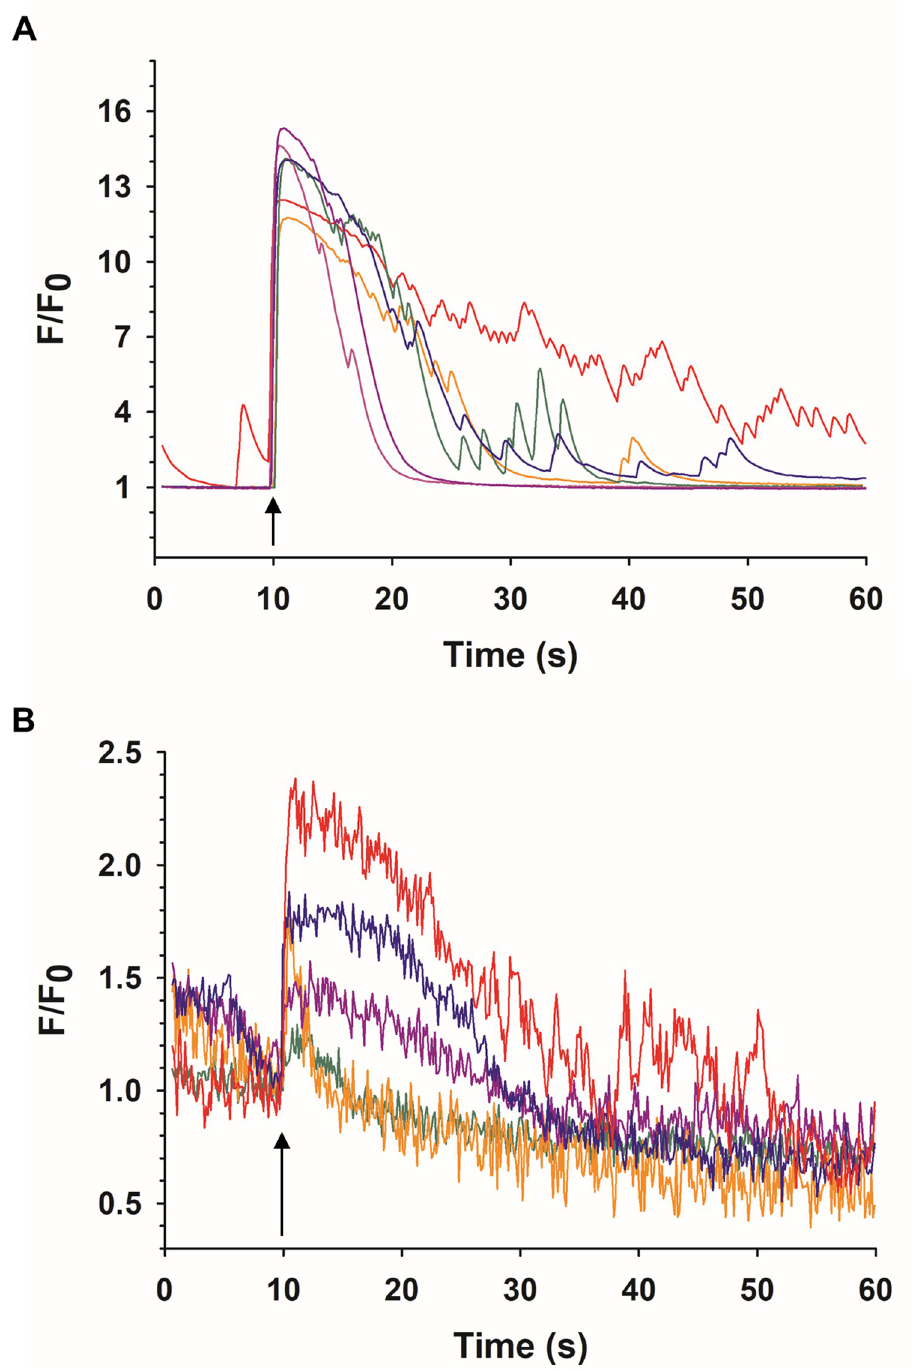
Fig 5. Effect of different GCaMP6f expression levels on DMPP-induced Ca 2+ responses in TH-GCaMP6f - expressing ACC. Representative fluorescence traces of Ca 2+ responses evoked by 50 μ M DMPP (arrows) in cells exhibiting (A) a “high” ( n = 3, c = 13) or (B) “low” ( n = 3, c = 8) level of GCaMP6f expression. In (B), photobleaching is evident by the drop in fluorescence intensity below F/F 0 = 1.